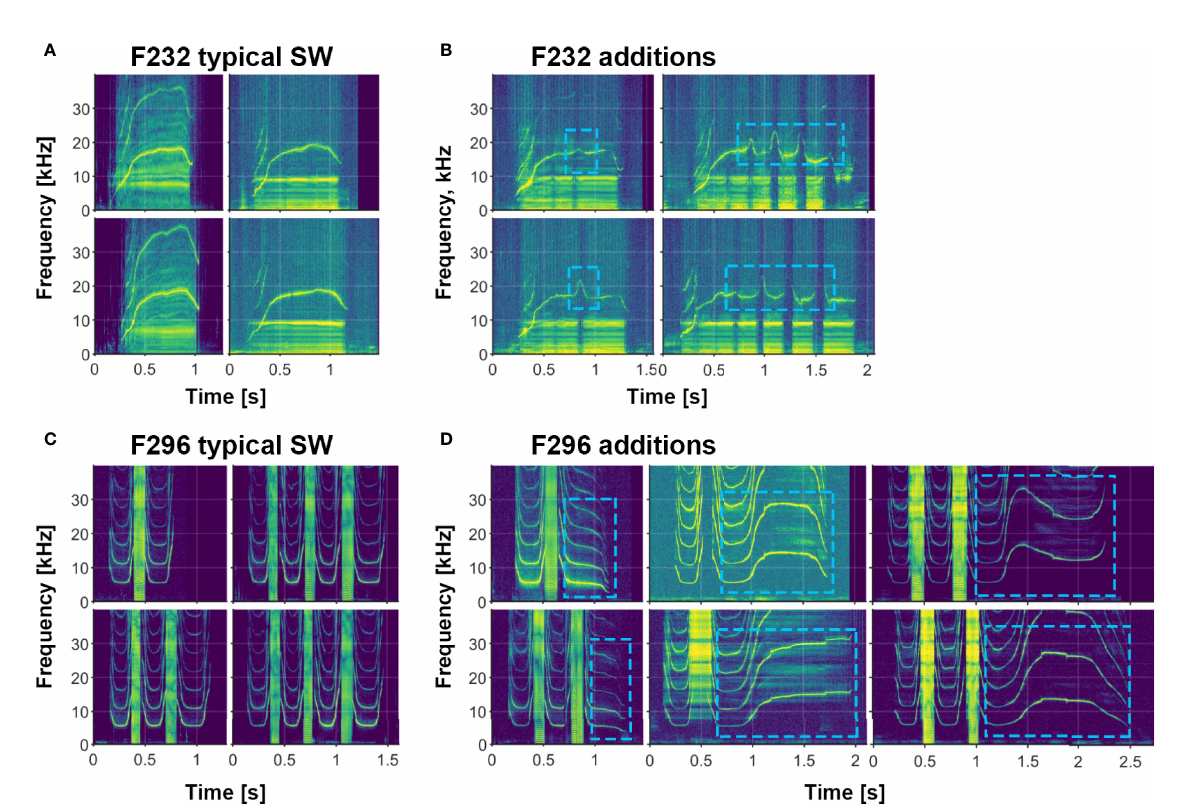
FIGURE 5 Examples of signature whistle additions and simultaneous burst-pulse components in two animals (F232 and F296). (A) Typical F232 signature whistle; note simultaneous whistle and burst-pulse components. (B) Signature whistle additions ranging from 1-4 in fl ections, all concurrent with gaps in burst-pulse component (marked by blue boxes). (C) Typical F296 signature whistle; note again concurrent burst-pulses. (D) Various additions (marked by blue boxes) that differ from the typical terminal